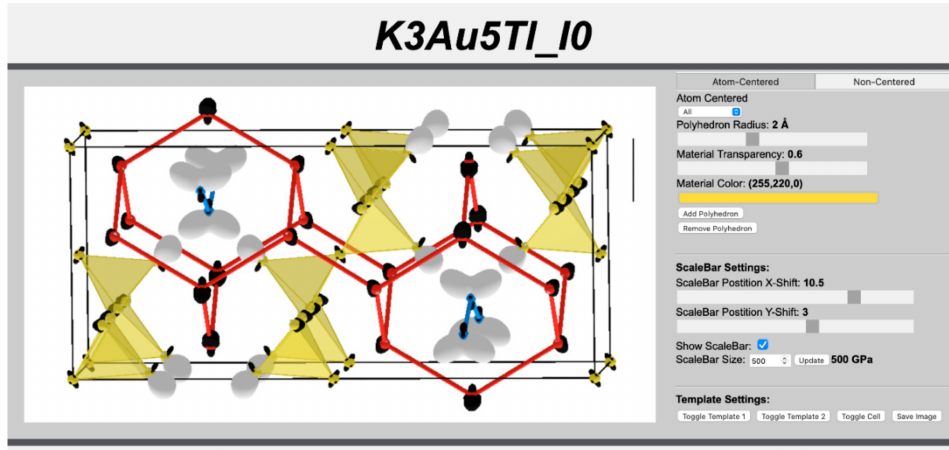
Figure 10. Adjustment of the scale of the CP features and the scale